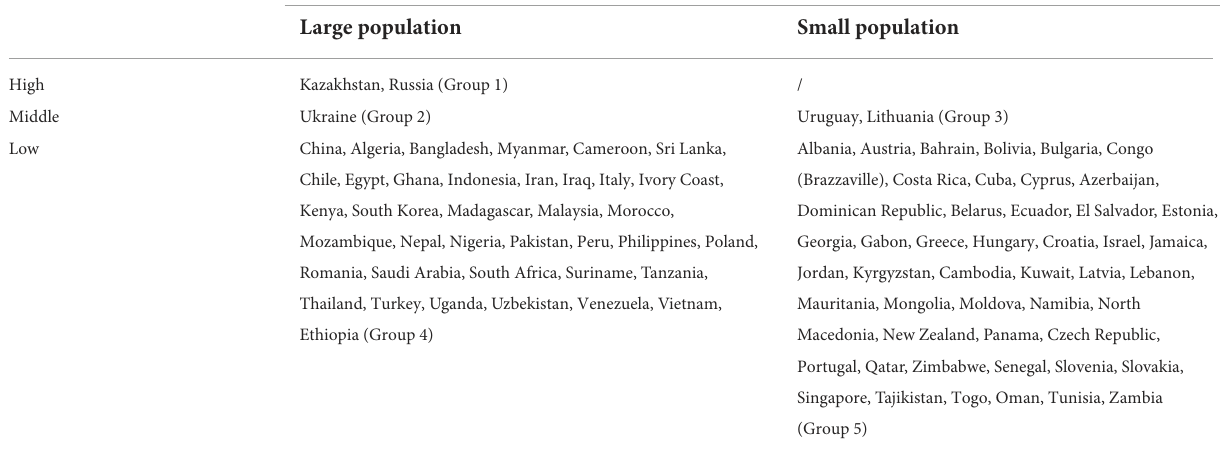
TABLE 4 Grouping results of threshold